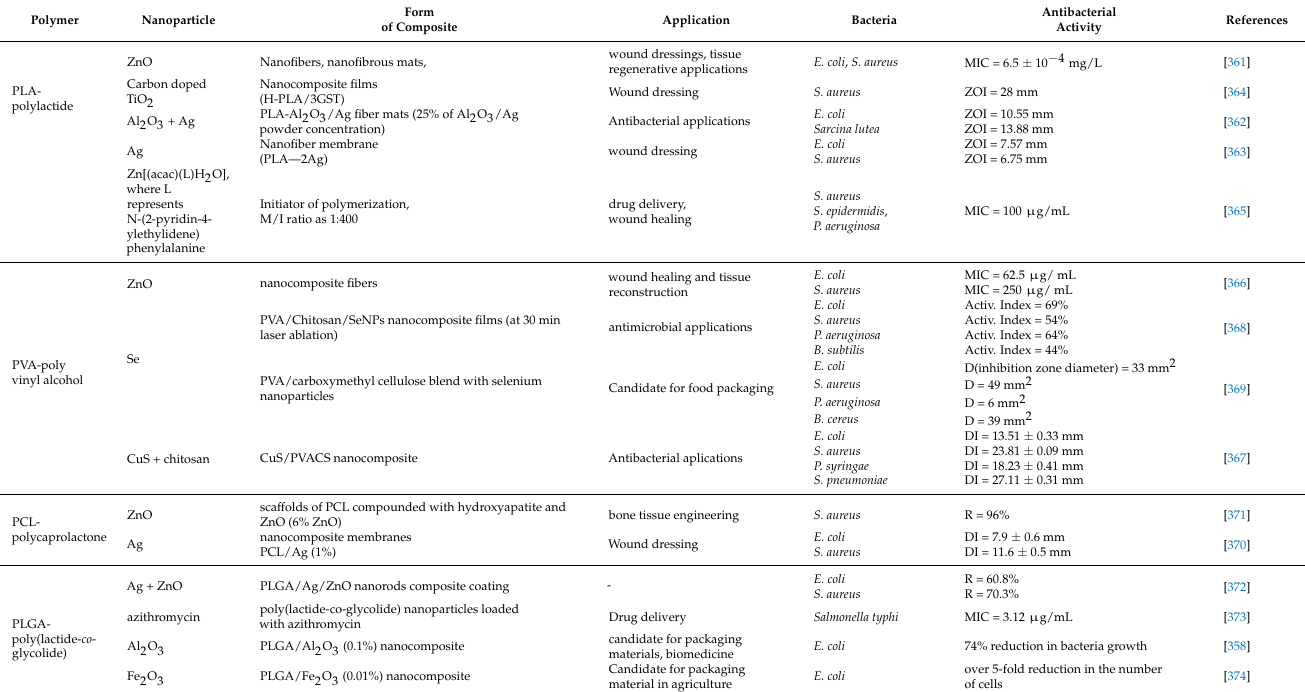
Table 5. Biodegradable polymer composites and their antibacterial